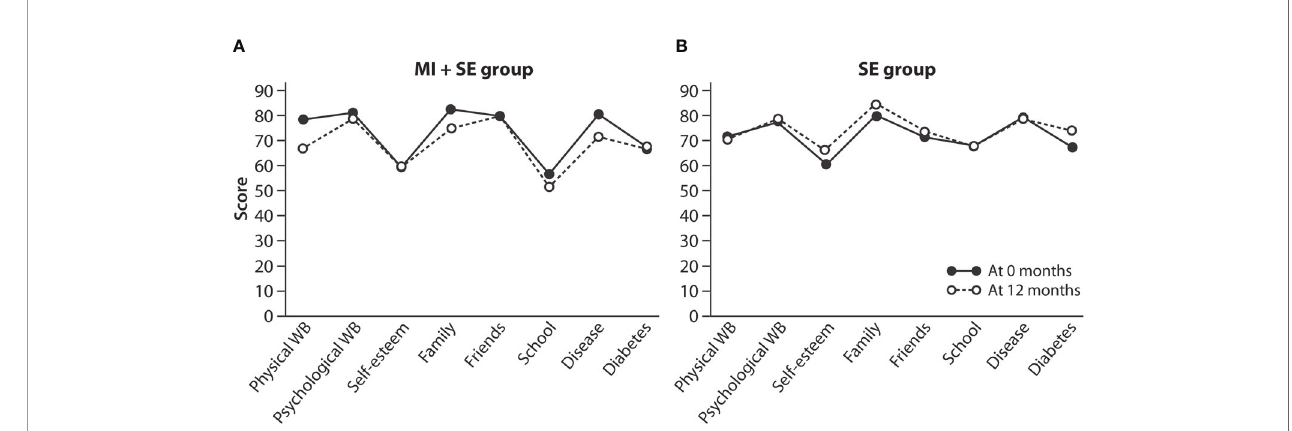
FIGURE 5 | Health-related quality of life, evaluated in Kiddo-KINDL terms, for the MI+SE group (A) and SE-only group (B) at baseline and 12 months. The values are